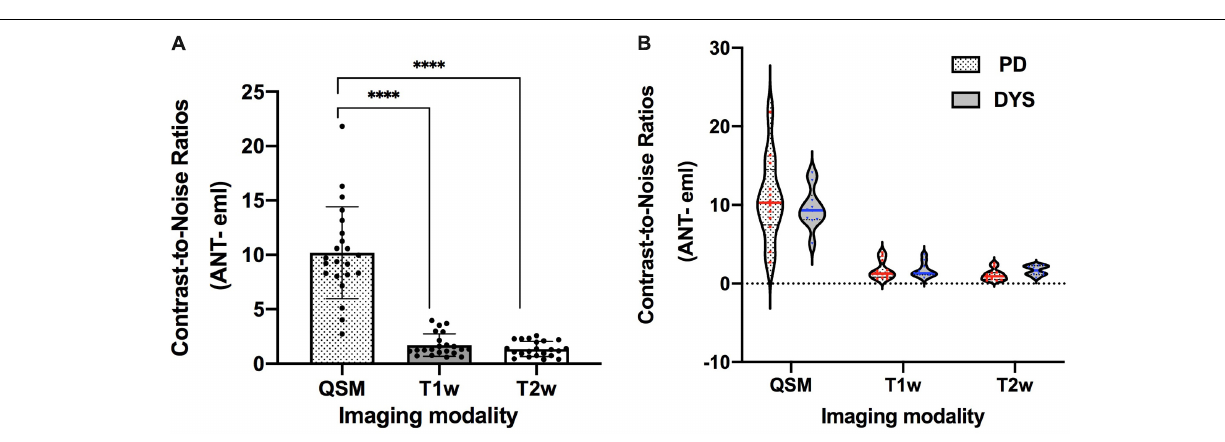
FIGURE 4 | The CNRs of the ANT relative to eml on 3 T QSM, T1w, and T2w. ∗∗∗∗ p < 0.0001. (A) One-way ANOVA indicated significant differences in CNRs among QSM, T1w, and T2w imaging modalities [ F (2) = 85.28, p < 0.0001]. Post hoc tests using independent-samples t -tests revealed significant differences in terms of CNRs between QSM and T1w [ t (21) = 9.156, p < 0.0001] and between QSM and T2w [ t (21) = 9.689, p < 0.0001]. (B) CNRs (ANT-eml) of different patient types on three imaging modalities were presented using the violin plot. Two-way ANOVA indicated that no interaction effects existed between the patient type and the